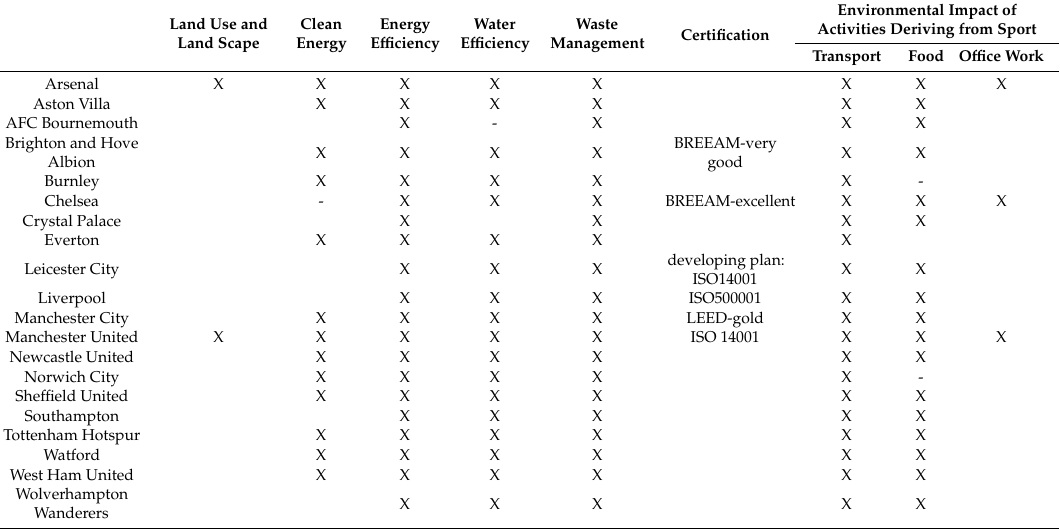
Table 2. Environmental protection activities of the teams in the Premier League. Land Use and Land